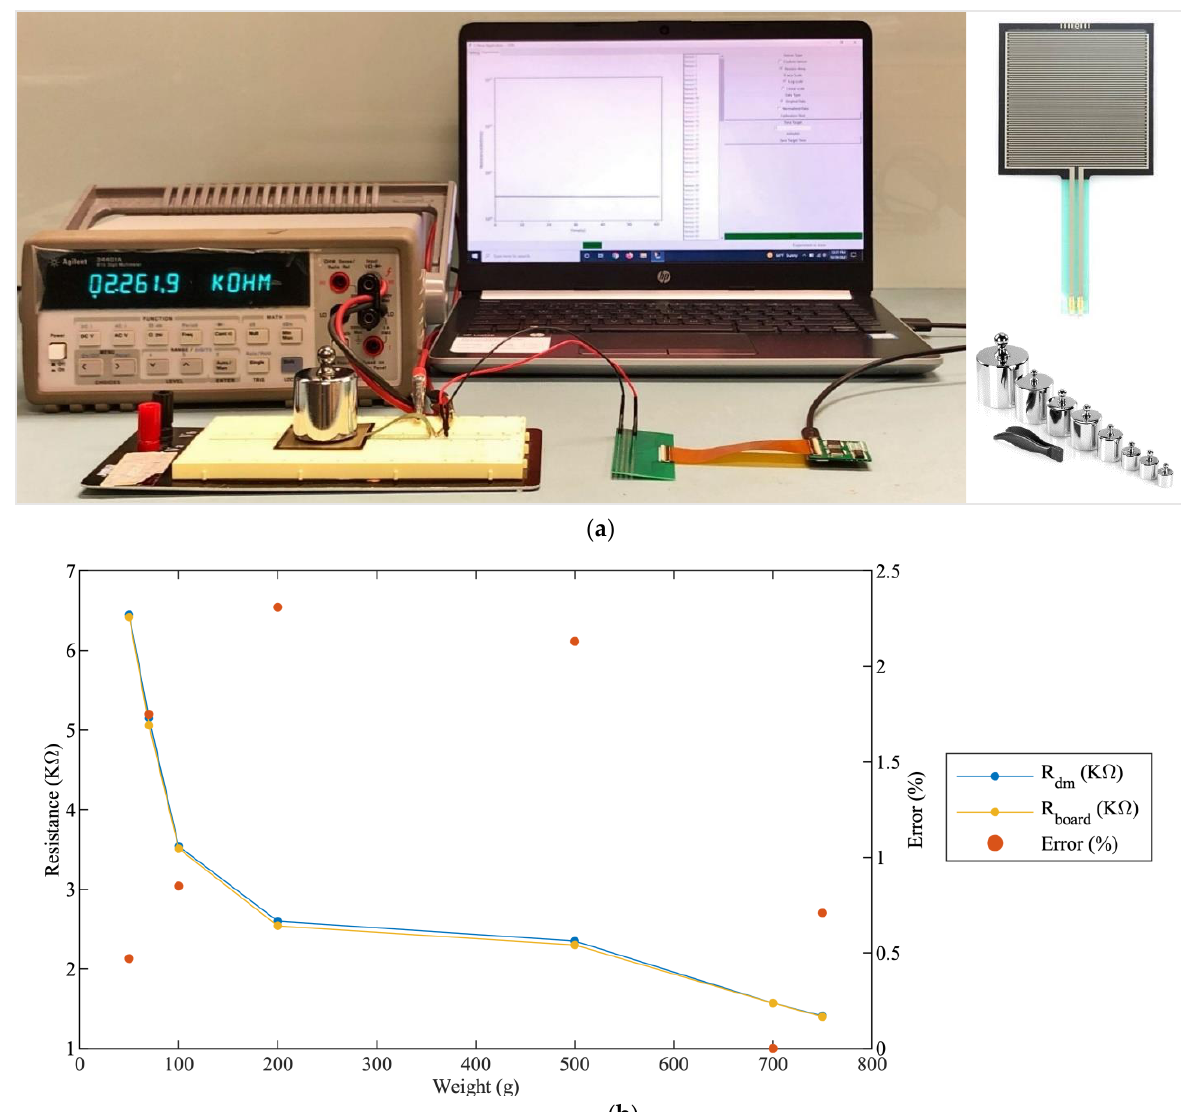
13 of 16 Figure 9. System ’s transient response: ( a ) 𝑅 𝑒𝑥𝑝 = 1 MΩ; ( b ) 𝑅 𝑒𝑥𝑝 = 750 KΩ; ( c ) 𝑅 𝑒𝑥𝑝 = 500 KΩ; ( d ) 𝑅 𝑒𝑥𝑝 = 100 KΩ; ( e ) 𝑅 𝑒𝑥𝑝 = 50 KΩ; ( f ) 𝑅 𝑒𝑥𝑝 = 10 KΩ . 3.2. Case Analysis 2: Test Setup with a Force-Sensitive Resistor and Sensor Testing Results As the second case analysis, the developed system was tested by interfacing with a commercially available force-sensitive resistor “ FSR-406 ” (Interlink Electronics ® , Cama- rillo, USA). The “ FSR-406 ” varies its resistance, depending on the force applied to the sensing area. The non-actuated sensor resistance is larger than 1 M Ω , and its resistance decreases exponentially as per the force applied on the sensing area. The sensor had a sensing area of 0.75 ” × 1.5 ” and can sense applied force in the range of 10 g to 10 Kg. During the experiment, “ FSR-406 ” was connected to the readout board, as illustrated in Figure 10a, and the sensor response measured by the readout board ( 𝑅 𝑏𝑜𝑎𝑟𝑑 ) was rec- orded throughout the applied weight range from 50 g to 750 g. Simultaneously, the sen-